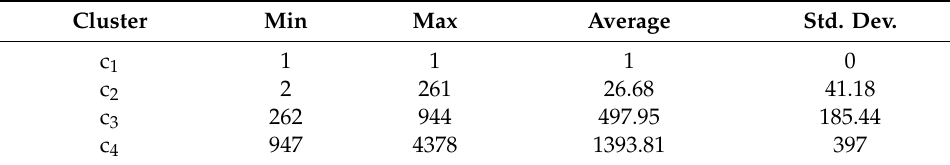
Table 1. User representation level clusters